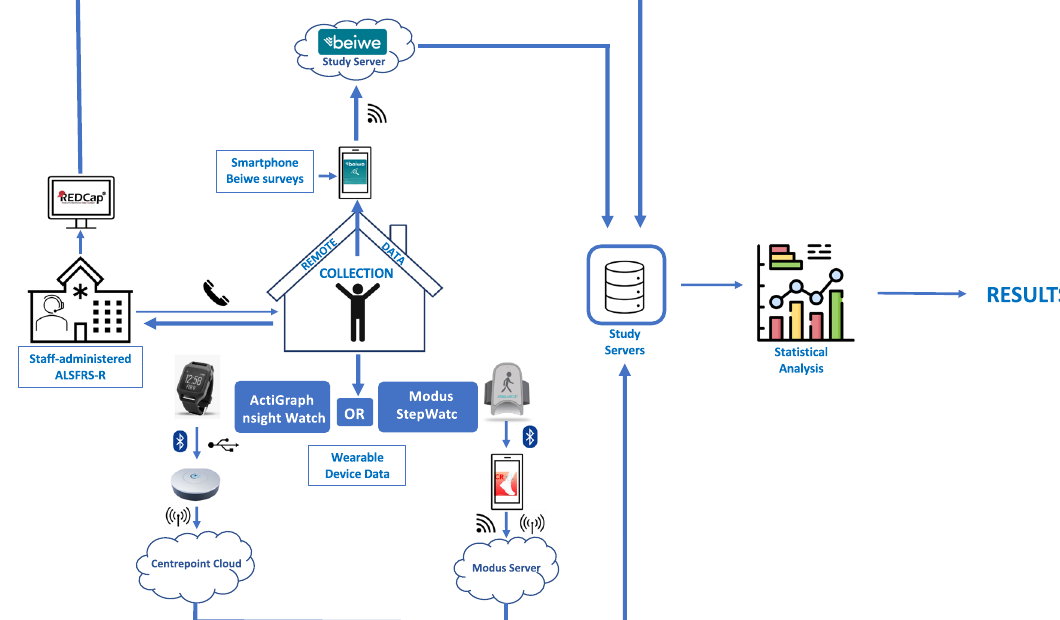
Fig. 3 Study data fl ow schematic. Each participant provided three data streams (blue text and white background thin-outline boxes). Thick blue arrows represent directionality of data. The small icons adjacent to the blue arrows represent the mode of data transfer: vertical oval with blue background and white lines (Bluetooth); dot with three curved lines (Wi-Fi); phone (study staff-initiated phone call); vertical line with curved vertical lines on either side (cellular). ALSFRS-R – Amyotrophic Lateral Sclerosis Functional Rating